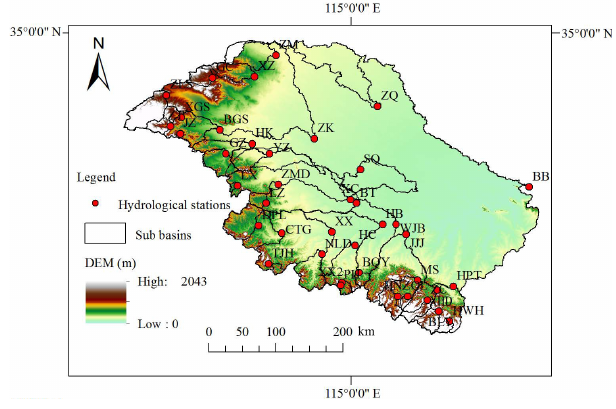
Figure 2. The sub-basins and hydrological stations in the study area.